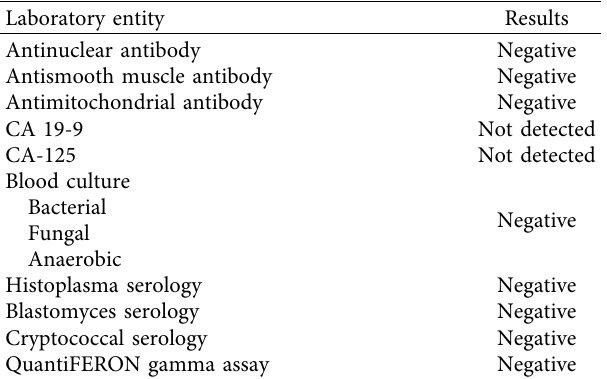
Table 2: Laboratory data to rule out other